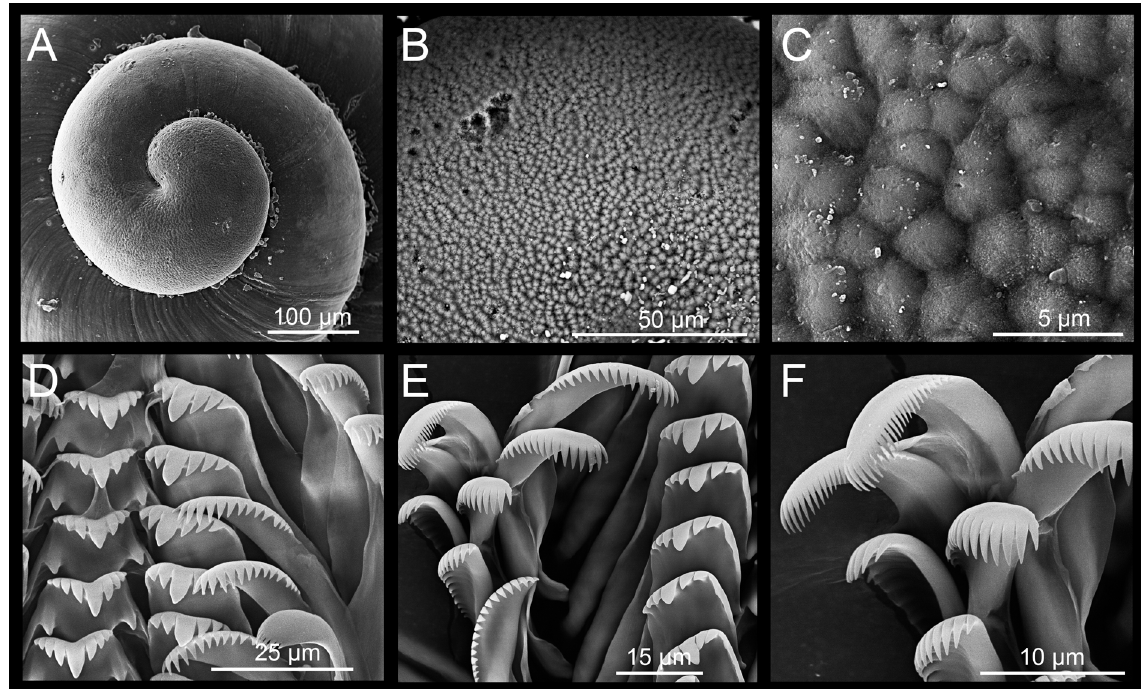
Fig. 24. Protoconch and radula of Mercuria felixi Miller, García-Guerrero & Ramos sp. nov. from